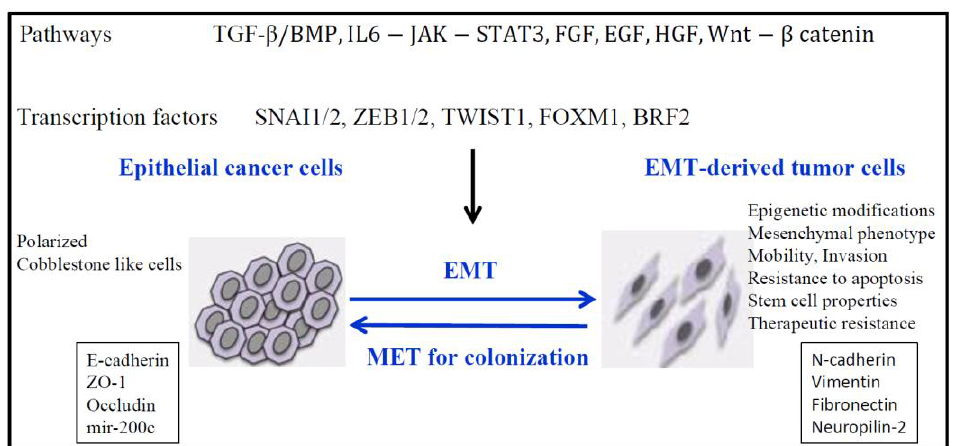
Figure 1. EMT (Epithelial to Mesenchymal transition ) and epigenetic modifications. EMT is induced by different pathways that involve different transcription factors necessary to repress epithelial genes and to activate mesenchymal genes.